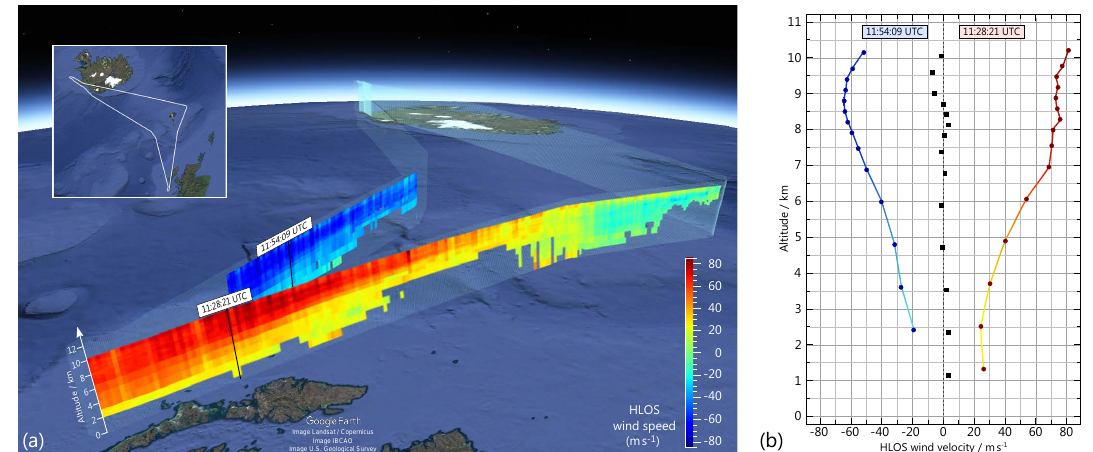
Figure 8. Flight track of the Falcon 20 aircraft for the research flight on 27 September 2016 together with the overlaid A2D HLOS wind profiles measured between 10:40 and 11:38UTC (foreground) as well as between 11:48 and 12:12UTC (background), whilst crossing the North Atlantic jet stream (background image: ©2017 Google). (b) Wind profiles from two selected observations starting at 11:28:21 and 11:54:09UTC. The black squares indicate the mean bias per range gate based on the comparison with wind data from the 2µm coherent wind lidar (see